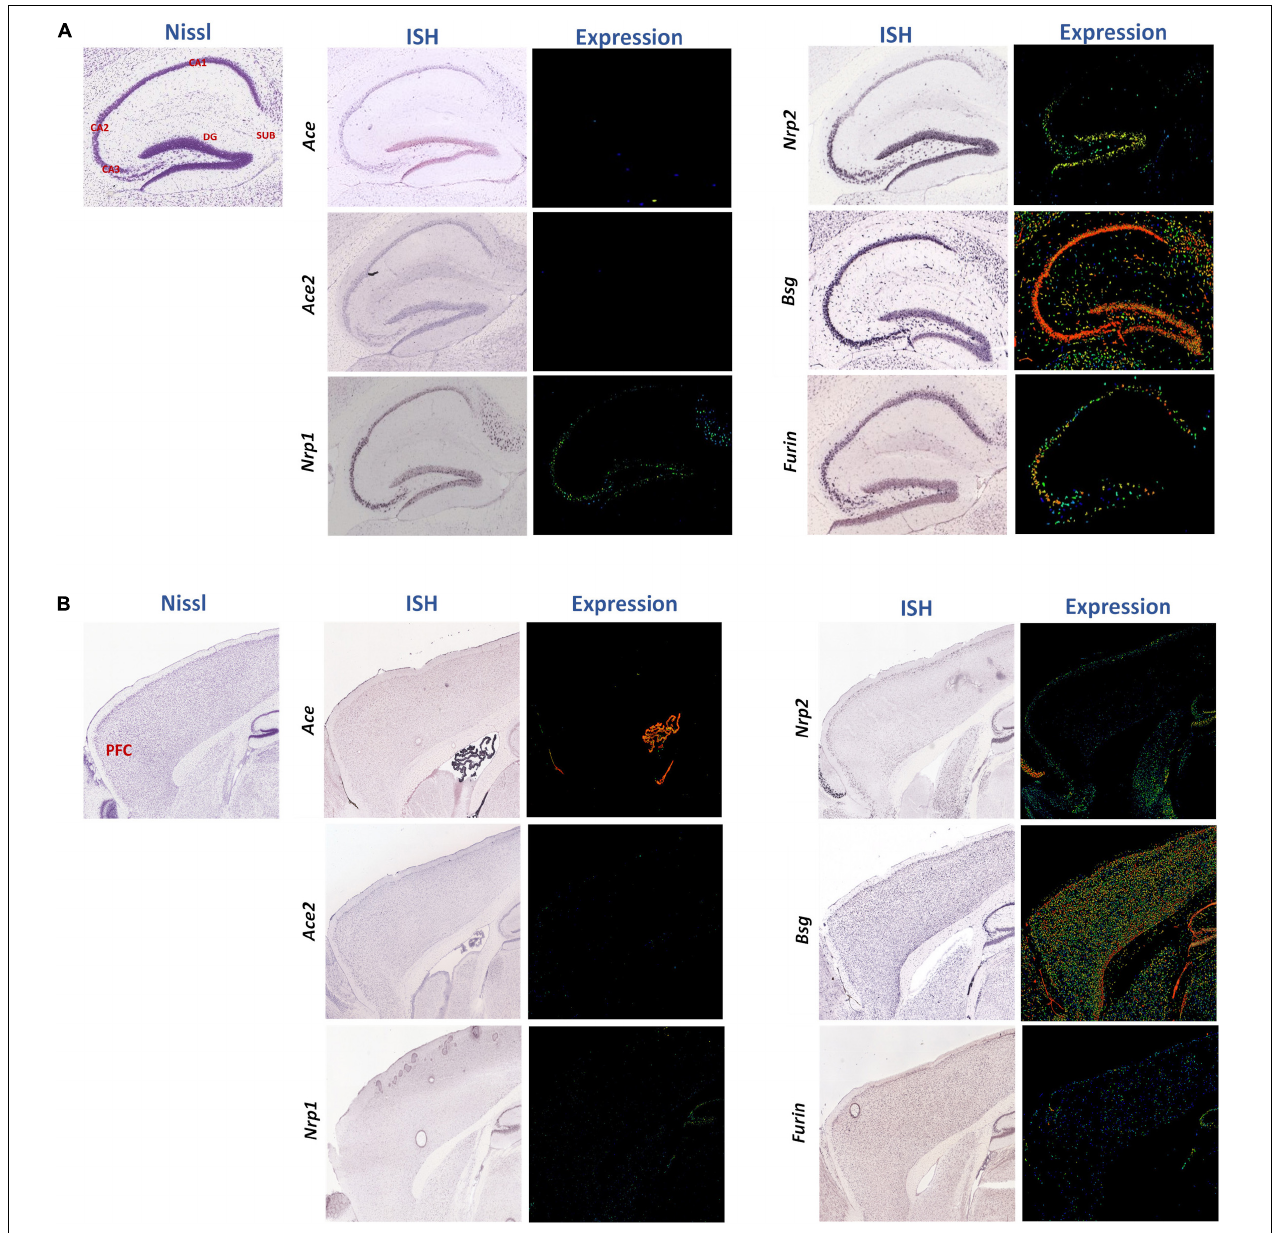
FIGURE 3 | Spatial distributions of the SARS-CoV-2 receptors in the sagittal sections of mouse hippocampus and PFC region. Spatial distributions of the SARS-CoV-2 receptors Ace , Ace2 , Nrp1 , Nrp2 , Bsg , and Furin in the mouse hippocampus (A) and cerebral cortex region (B) were studied. In representative Nissl images, the cornu ammonis (CA)1, CA2, CA3, dentate gyrus (DG), and subiculum (SUB), and PFC are labeled in red. The middle and right columns represent ISH and pseudo-colored expression images, respectively. Blue, green, and red pseudo-colors encode staining intensities (low, medium, and high) in expression images, respectively. All images were downloaded from the Allen Mouse Brain Atlas (©2004 Allen Institute for Brain Science) (Lein et al.,